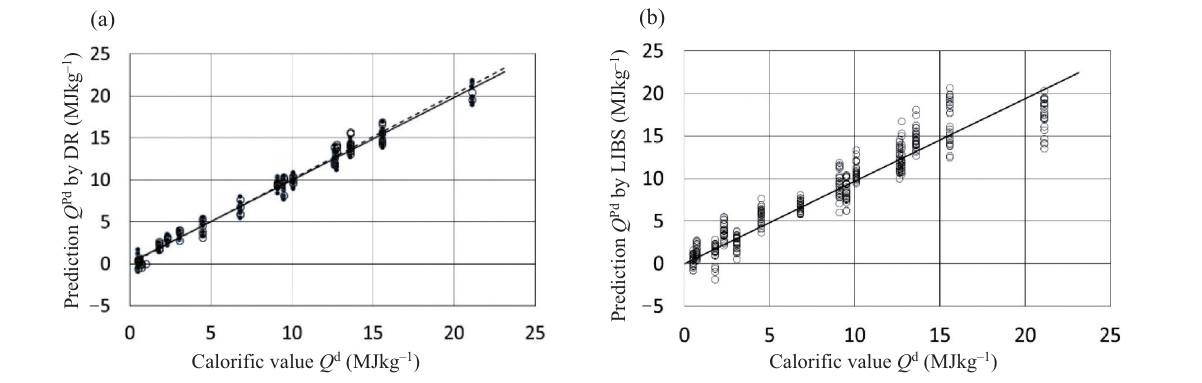
Fig. 5. (a) DR results: test set validation of calorific value Q Pd ; filled symbols – calibration data and dashed line – linear fit for cali­ bration; open symbols – prediction data and solid line – linear fit for prediction. (b) LIBS results: cross validation of calorific value Q Pd ; data taken from